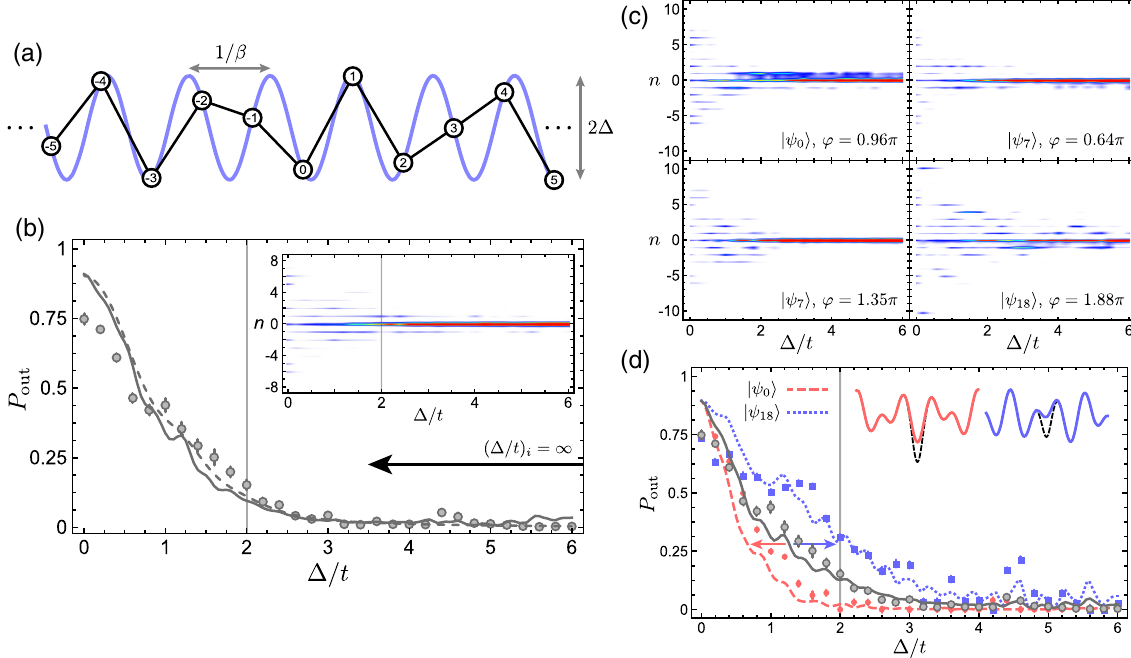
FIG. 3. Localization in the 1D AA model with NN tunneling. (a) Lattice site energies under the AA model of quasiperiodic disorder, ffiffiffi p ε Δ cos ð 2 πβ n þ φ Þ , for periodicity β ¼ ð 5 − 1 Þ = 2 and amplitude Δ . (b) Measured population outside the central three lattice sites n ¼ ( P ) versus disorder-to-tunneling ratio Δ =t , averaged over four values of the AA phase φ = π ¼ f 0 . 96 ; 0 . 64 ; 1 . 35 ; 1 . 88 g . These φ values out correspond to the energy eigenstates fj ψ 0 i ; j ψ 7 i ; j ψ 7 i ; j ψ 18 ig , where j ψ 0 i is the ground state and j ψ 20 i is the highest excited state. Dashed and solid curves represent ideal and full simulations of experimental parameters, respectively. Arrow indicates experimental ramp from ð Δ =t Þ i ¼ ∞ to some final disorder value. Inset: Integrated OD image showing site populations versus disorder strength, also averaged over the four eigenstates. (c) Integrated OD images for the individual eigenstates, labeled with the relevant AA phase value. (d) P versus disorder strength for eigenstates j ψ 0 i (red circles) and j ψ 18 i (blue squares). Gray circles are the averaged data of (c). out Dashed red, dotted blue, and solid gray curves represent full simulation results including interactions of strength U= ℏ ≈ 2 π × 500 Hz, for j ψ 0 i , j ψ 18 i , and the averaged data, respectively. Inset: Illustration depicting lattice site energies for initial sites with low (left, red) and high (right, blue) energy. Dashed lines show the effect of attractive interactions on the initially populated central site. Vertical lines in (b) and (d) indicate the critical disorder ð Δ =t Þ c ¼ 2 for an infinite system without interactions. Error bars in (b) and (d) denote 1 standard error of the mean. OD images in (b) and (c) are plotted with the color scale in Fig.